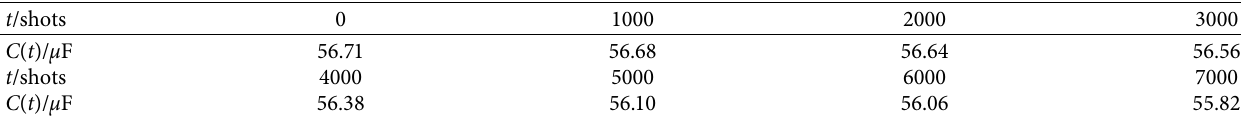
Figure 1: Capacitance degradation curves. Table 1: Capacitance of No. 9